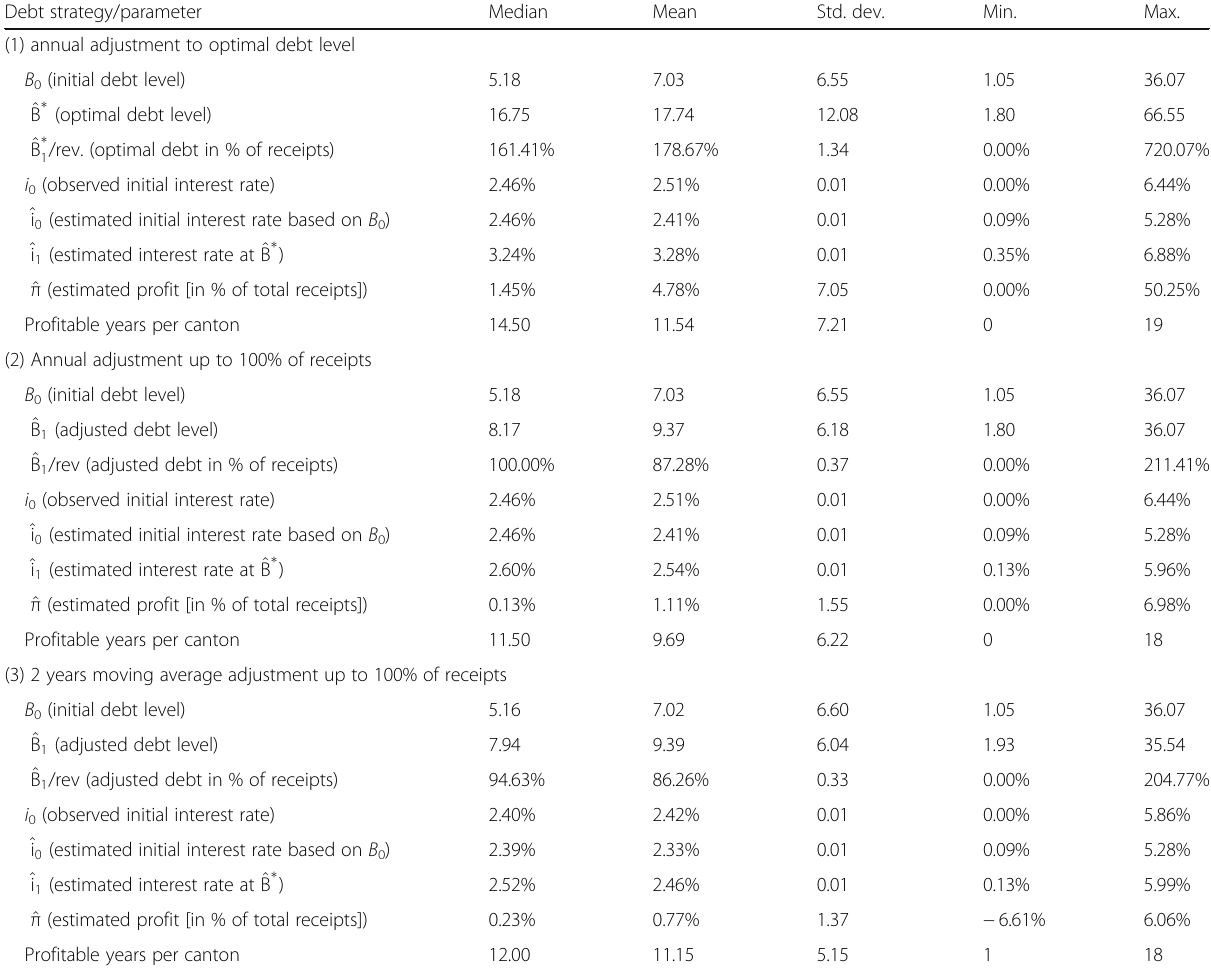
Table 2 Descriptive statistics of profit sensitivity Debt strategy/parameter